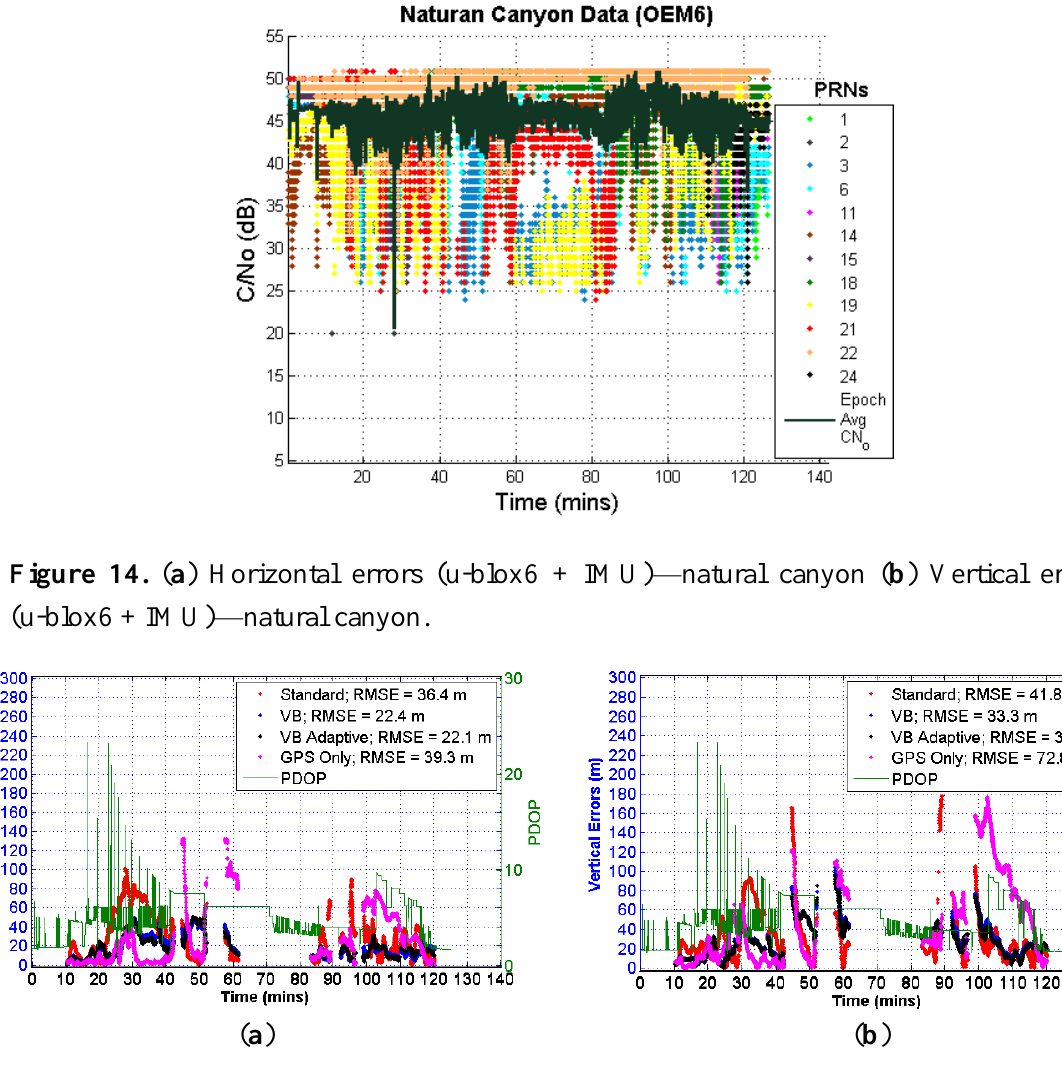
Figure 13. C/N values of measurements in natural canyon (OEM6). o